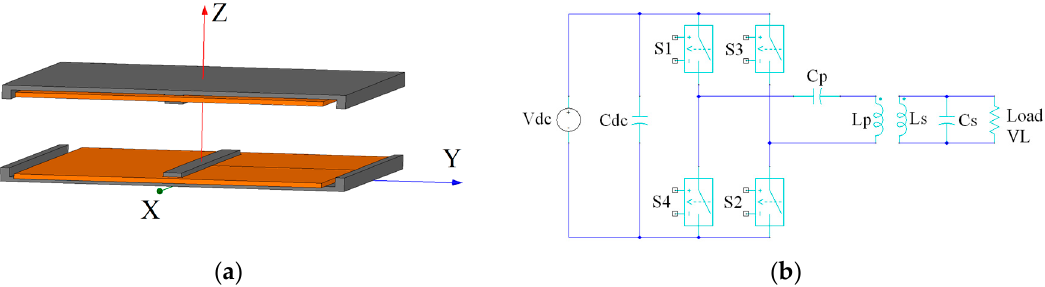
Figure 11. IPT system based on finite element analysis (V dc : 300 V; fsw: 20 kHz; air gap: 150 mm). ( a ) 3D Model of EE ‐ shaped ferrite cores; ( b ) Circuit of the SP topology.